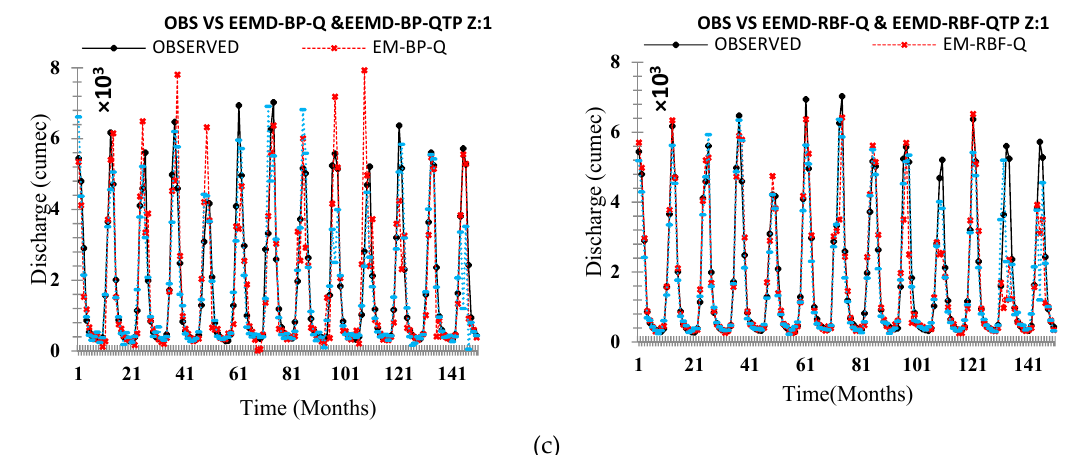
Figure 14. Comparison of the originally observed streamflow and the simulated runoff hydrograph Zone One ( a ) OBS VS ANN (Q & QTP) Inputs, ( b ) OBS VS ANN-DWT (Q & QTP) Inputs, and ( c ) OBS VS ANN-EEMD (Q & QTP) Inputs.